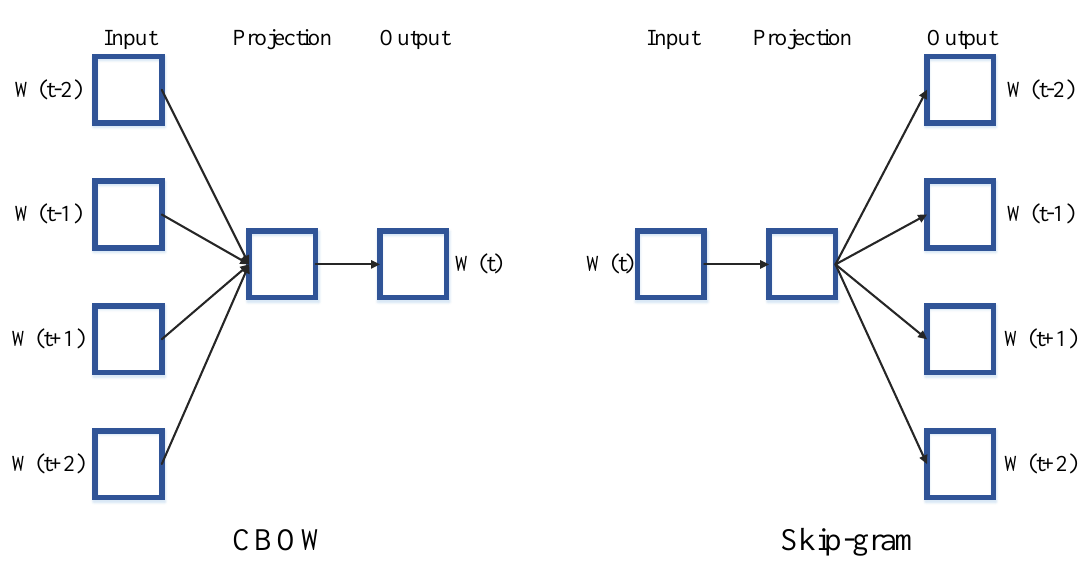
Figure 2. The continuous bag-of-words (CBOW) architecture predicts the current word based on the context, and the Skip-gram predicts surrounding words based on the given current word